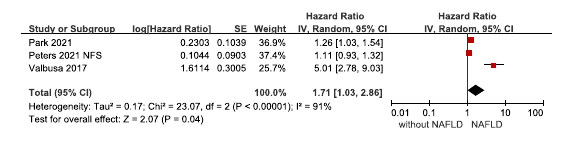
FIGURE 4 Association between NAFLD and the risk of all-cause/cardiac hospitalization or rehospitalization in patients with heart failure. CI, con fi dence interval; NAFLD, non-alcoholic fatty liver